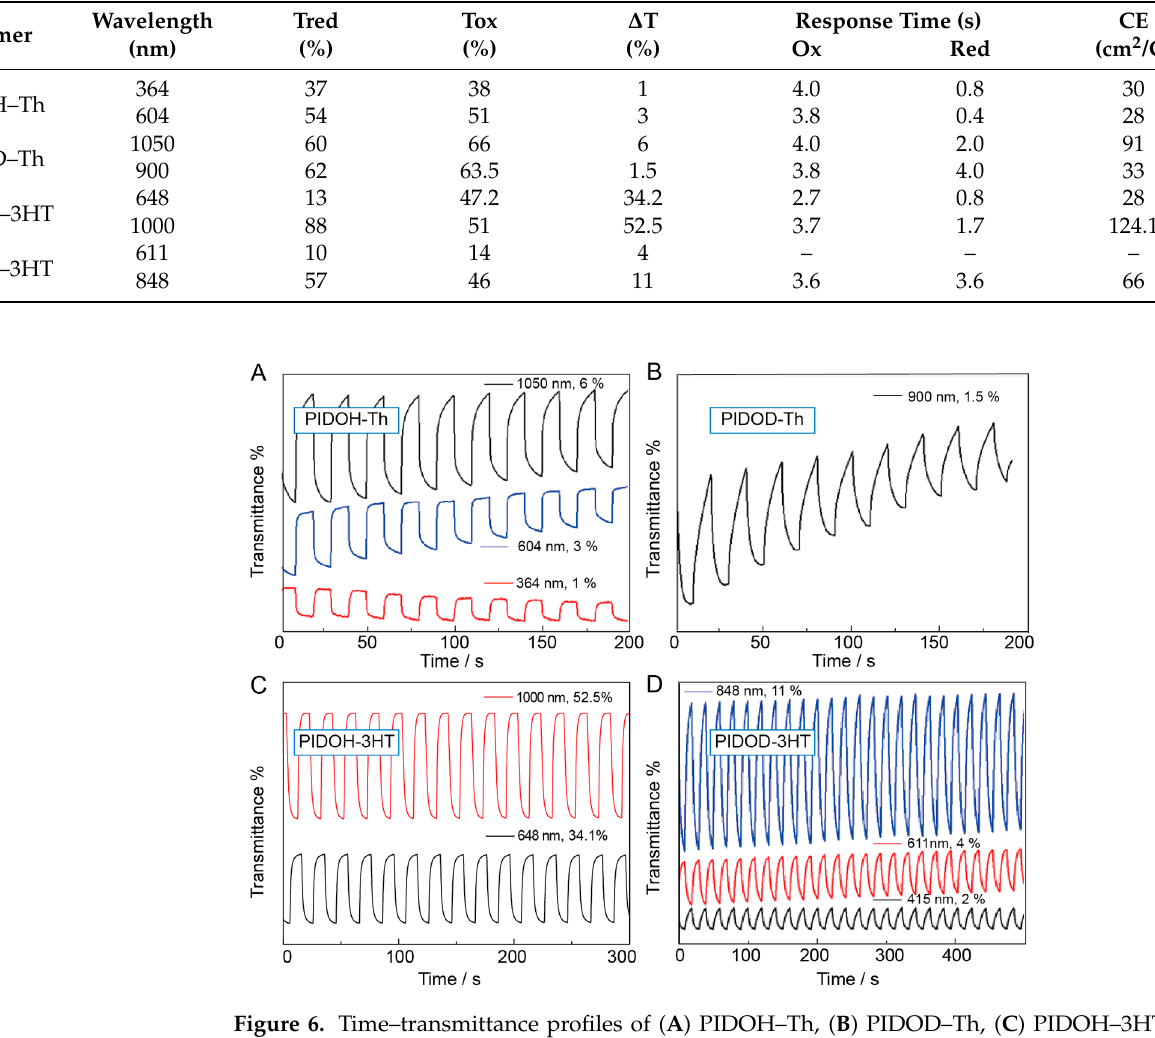
Table 2. Electrochromic parameters of isoindigo–based D–A–D–type polymers.